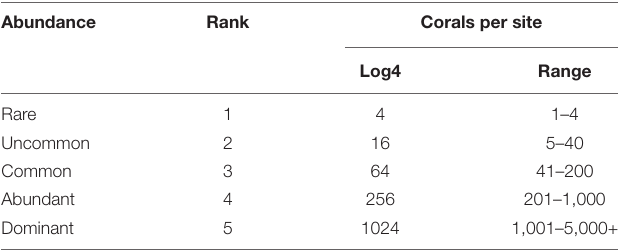
TABLE 2 | Local relative abundance ranks and equivalent log 4 conversions and approximate ranges in colony